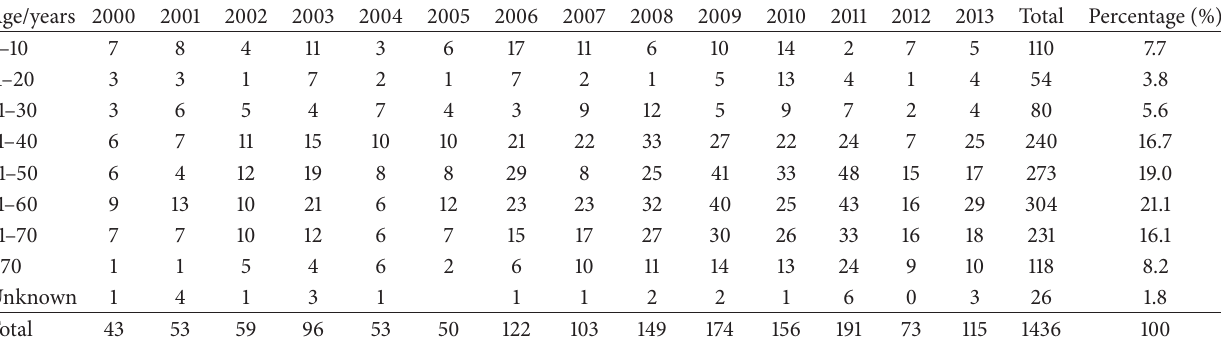
Table 2: Showing yearly incidence and age